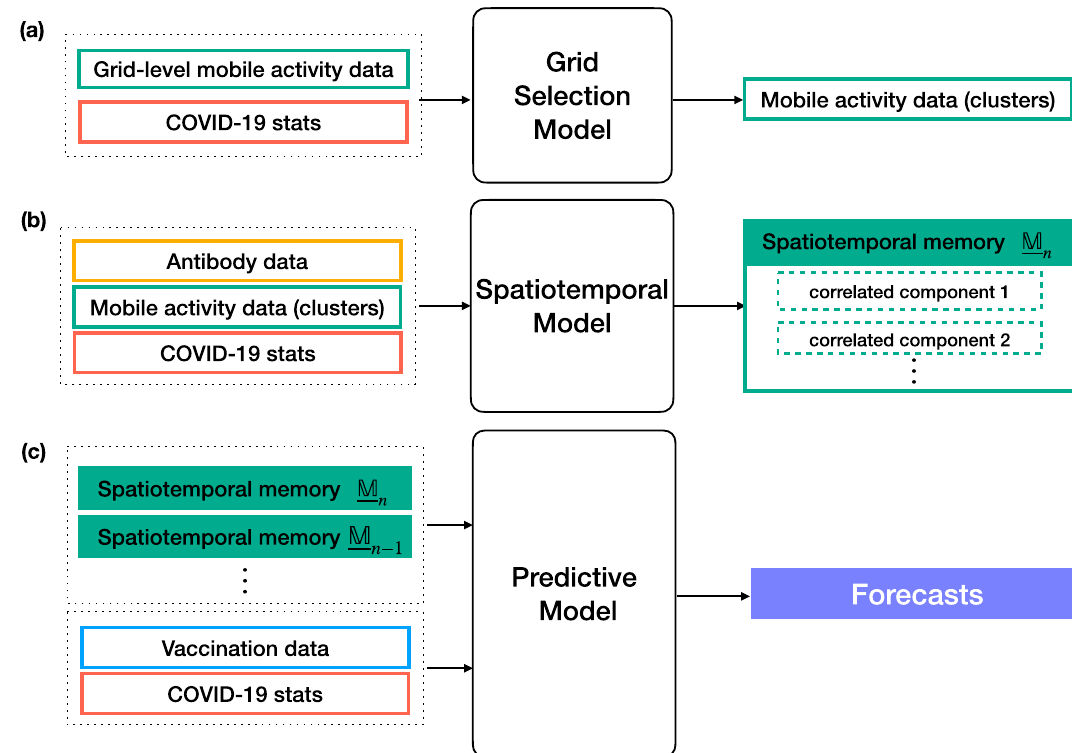
Figure 1. Modular description of the forecast model pipeline and its main components. ( a ) The grid selection model selects clusters of grids from mobile activity data that are best reflective of user activities in relation to COVID-19. ( b ) The spatiotemporal model uses hourly mobile activity data from selected clusters of grids and constructs a spatiotemporal memory of correlated components. These correlated components are the latent spatiotemporal patterns in mobile activity data that are either statistically positively or negatively correlated with daily number of admitted COVID-19 patients. ( c ) The predictive model uses historical frames of spatiotemporal memory matrices, together with historical COVID-19 admission data and vaccination data, in order to produce the predicted number of admitted patients for the duration of the forecast